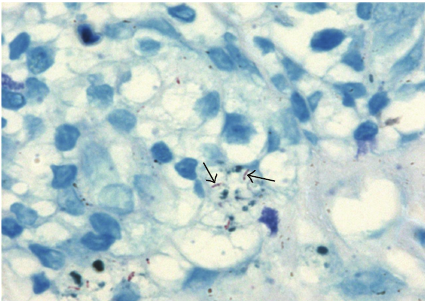
Figure 3: Ziehl-Neelsen stain showing acid-fast bacilli (arrows,